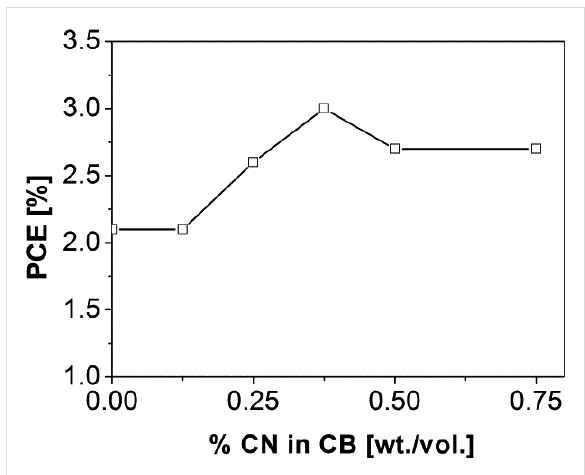
Figure 4: Power conversion efficiency of DCV5T-Bu 4 :PC 61 BM solu- tion-processed solar cells as a function of CN content in CB.